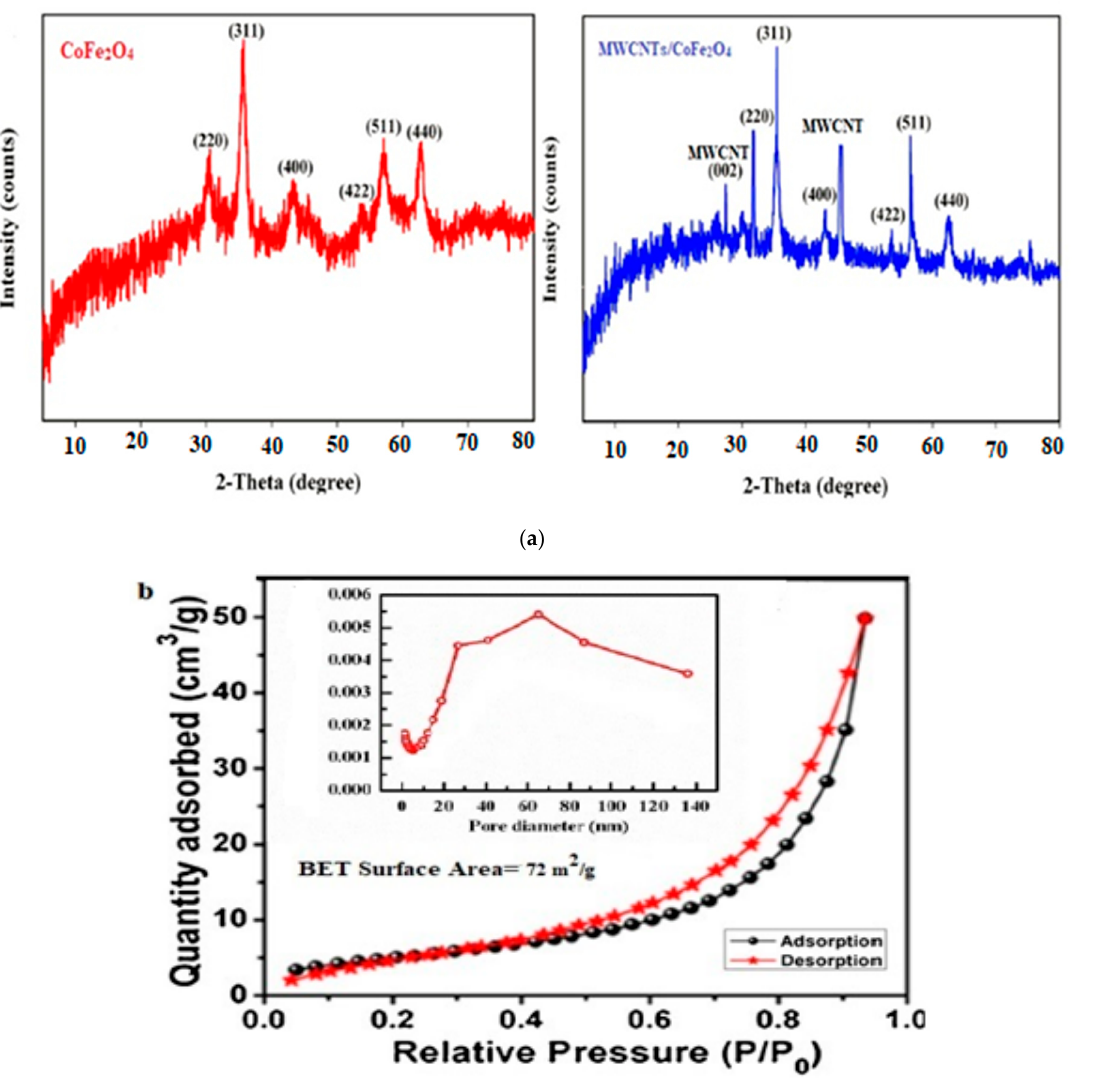
Figure 3. XRD patterns of the CoFe 2 O 4 and MWCNTs/CoFe 2 O 4 ( a ), and N 2 adsorption–desorption isotherms and pore size distribution ( b ).